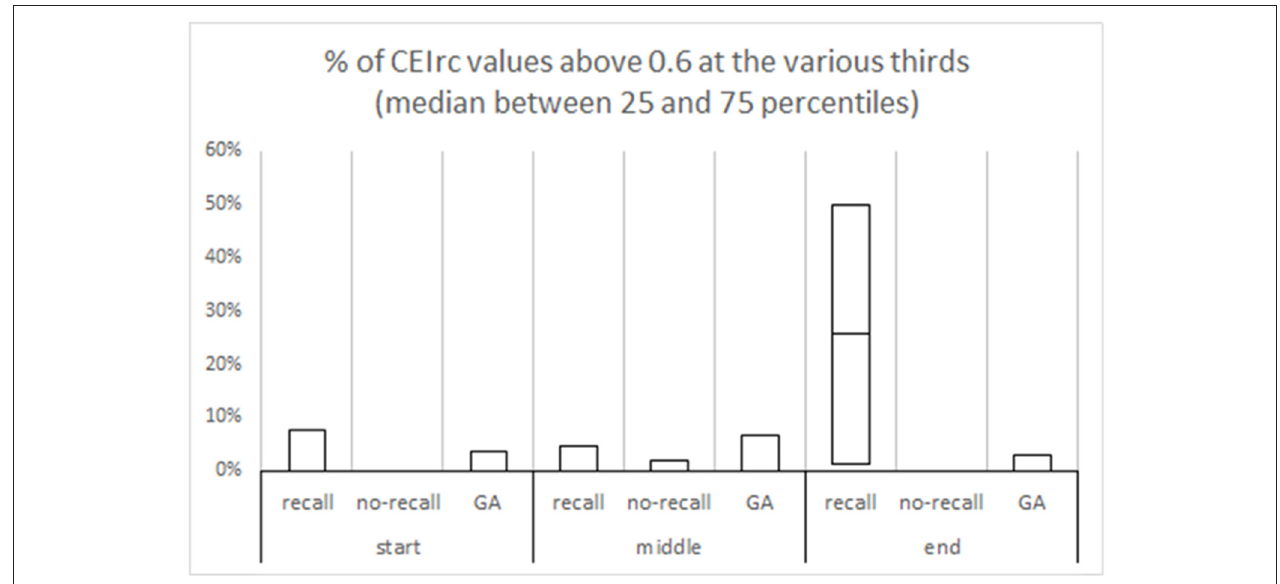
FIGURE 4 | % of CEIrc above the 0.6 threshold in different parts of the procedure. Each procedure duration was divided to three equal parts—start, middle and end. In each part, the median and the inter quartile range are presented for each group (sedation with recall; sedation with no-recall; GA with